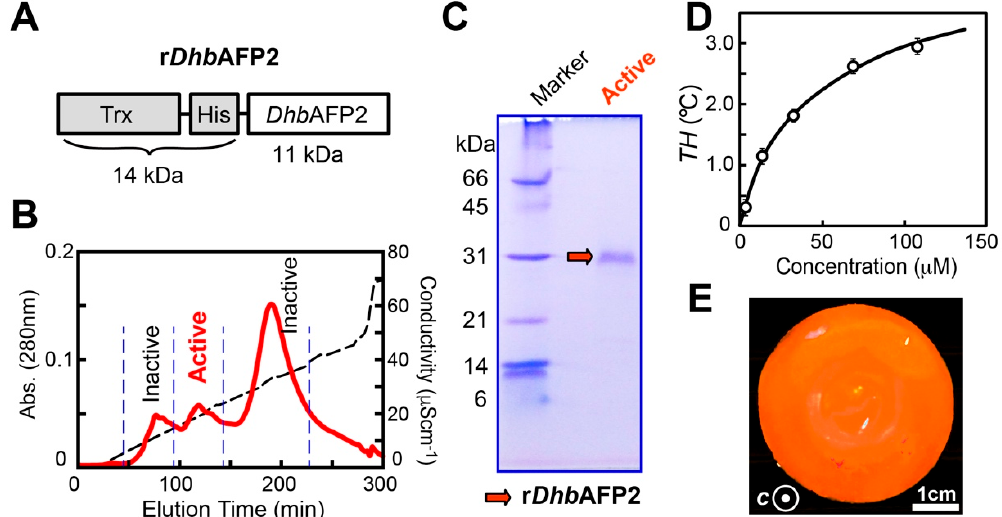
Figure 3. Preparation of a recombinant Dorcus hopei binodulosus ( Dhb) AFP2 isoform as a fusion protein. ( A ) A schematic representation of r Dhb AFP2 composed of thioredoxin (Trx), histidine tag (His), and the 109-residue Dhb AFP2 isoform connected in tandem. ( B ) The UV absorbance (280 nm) profile of r Dhb AFP2 obtained with High-Q anion-exchange chromatography using an NaCl gradient (0–70 μ S cm − 1 ). The lemon-like ice crystal and thermal hysteresis ( TH ) was detected for the “active” peak. ( C ) SDS-PAGE of the r Dhb AFP2 sample purified with Ni-column chromatography. ( D ) Concentration dependence of TH values of r Dhb AFP2. The measurement was performed in triplicate to draw error bars representing standard deviation. ( E ) A photograph of a single ice-crystal hemisphere, on which fluorescent (orange) r Dhb AFP2 adsorbs entirely to illuminate the whole surface under UV light.